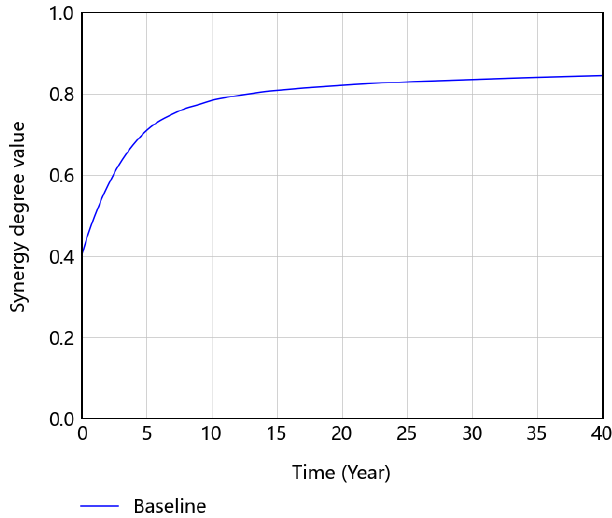
Figure 10. The changing curve of degree of synergy.